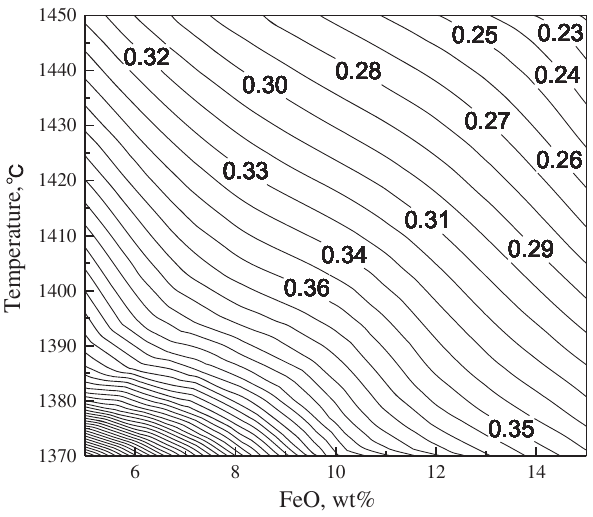
Figure 10: Influence of FeO and temperature on viscosity for MgO/